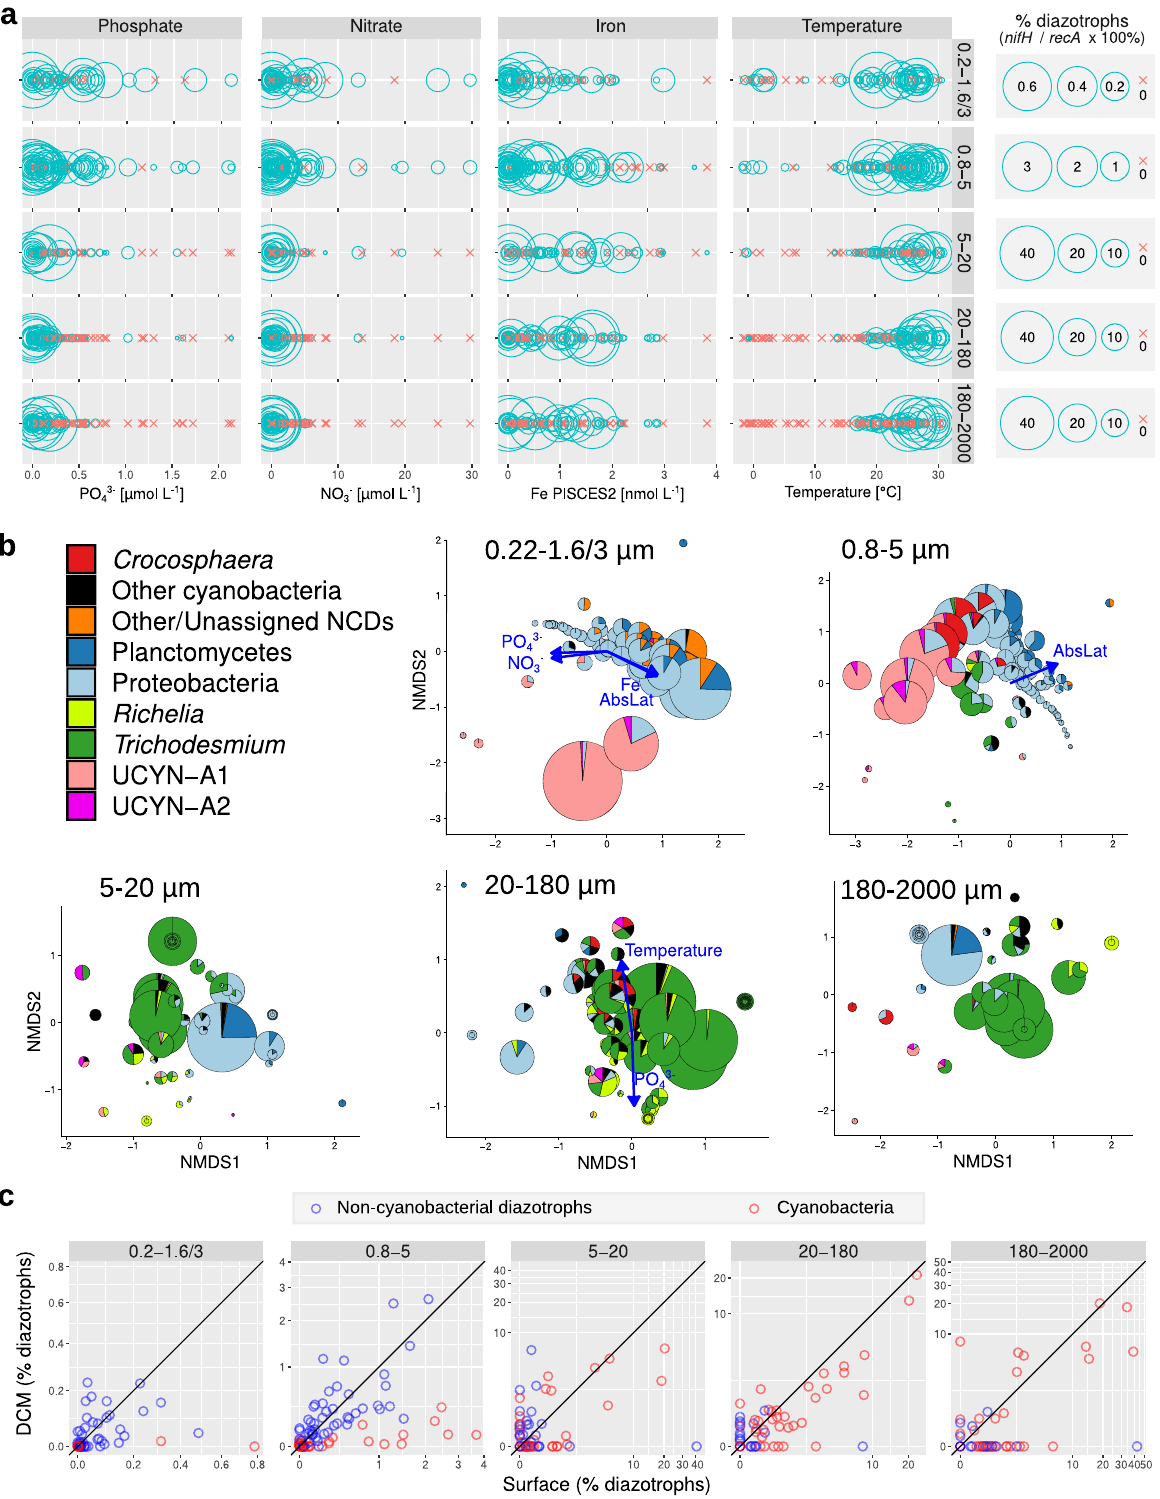
Fig. 8 Environmental parameters and diazotroph distributions. a Distribution across gradients of nutrients and temperature in surface waters. Blue circles correspond to samples with diazotrophs, while red crosses indicate absence (i.e., no detection of nifH reads). b NMDS analysis of stations according to Bray – Curtis distance between diazotroph communities of size-fractionated surface samples. Fitted statistically signi fi cant physico-chemical parameters are displayed (adjusted P value < 0.05). NMDS stress values: 0.07276045, 0.1122258, 0.1452893, 0.09693721, and 0.07969211. c Depth distribution. The scatter plots compare the diazotroph abundances between surface (5 m) and deep chlorophyll maximum (DCM; 17 – 180 m) for cyanobacteria (red points) and non-cyanobacterial diazotrophs (NCDs, blue points). Axes are in the same scale and the diagonal line corresponds to a 1:1 slope. Source data are provided as a Source data fi